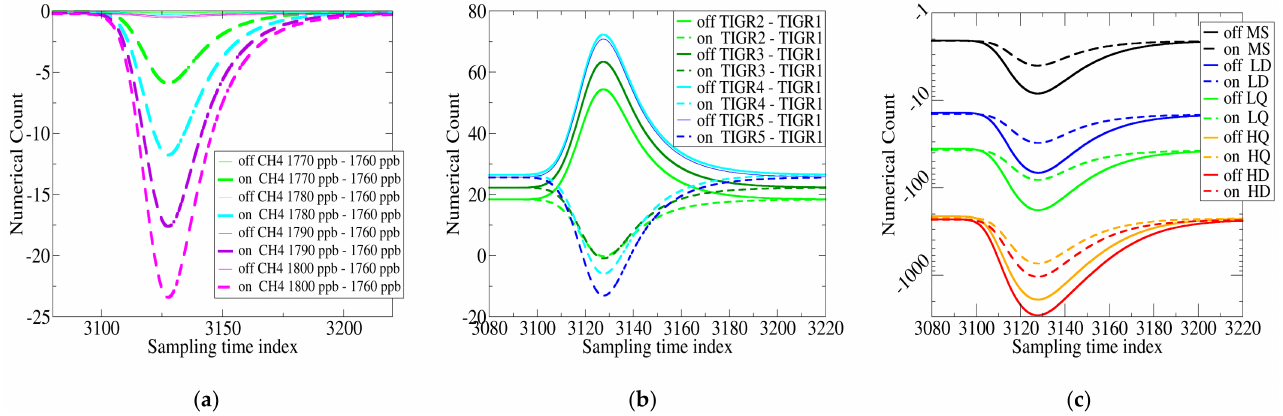
Figure 17. Sensitivity of the Off and On laser pulse records to ( a ) the methane content, ( b ) the TIGR atmosphere used [24], ( c ) the aerosol content (see Figure 6, MS: molecular scattering only). For the reference experiment, the maximum value is 4762 for the Off signal and 2788 for the On